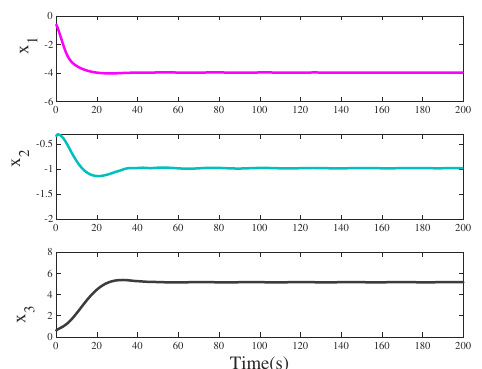
Figure 5. State responses of triggering control systems without aperiodic DoS attacks.